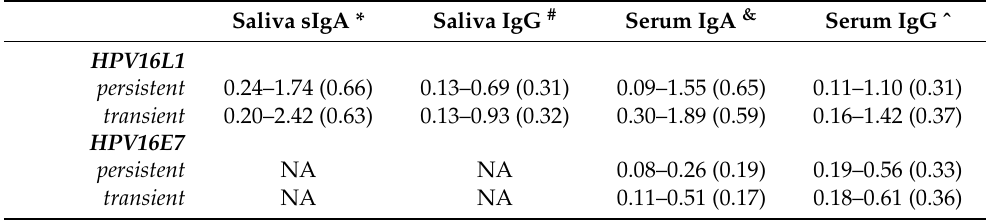
Table 2. The ELISA-values (A450) of saliva and serum samples from individuals with persistent or transient oral HPV16 infection, min-max (median). Note different dilutions in different assays.